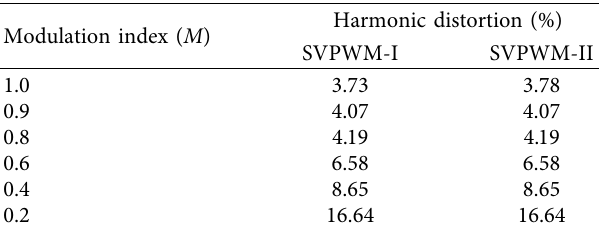
Figure 25: Experimental FFT of load current at M � 1.0. (a) SVPWM-I. (b) SVPWM-II. Table 12: Experimental line voltage THD for diferent modulation